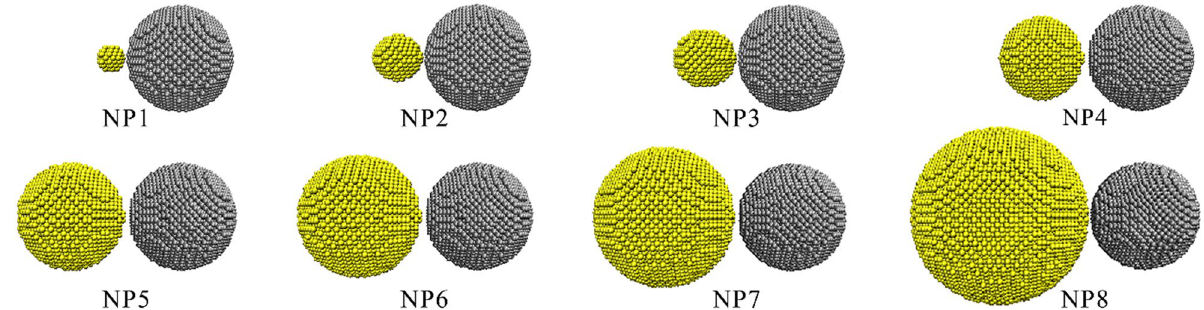
Figure 1. Initial configurations of Ni-Au NPs structures with different atomic ratio, Au and Ni atoms are colored in yellow and gray,